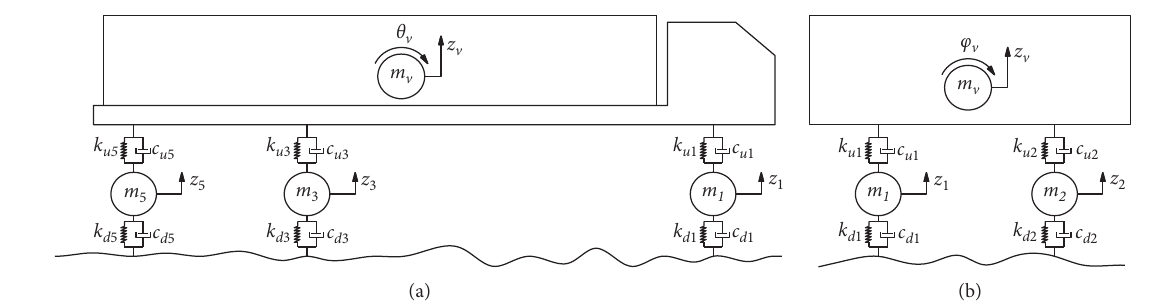
Figure 3: Layout of vehicles on bridge deck (unit: cm).